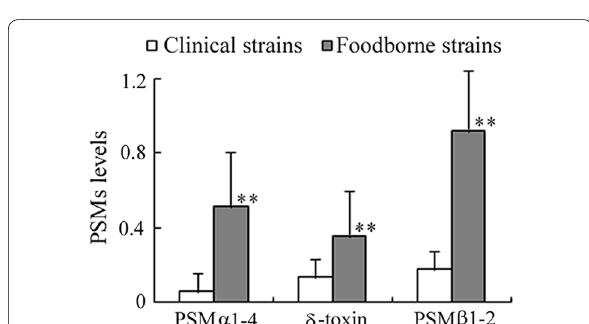
Fig. 2 PSMs expression in foodborne and clinically-derived S. aureus . The PSMα1-4, δ-toxin and PSMβ1-2 levels in foodborne strains were significantly higher than those in clinical strains, respectively. Results were expressed as the ratio of PSMs levels in tested strains to those in USA300. ** p <